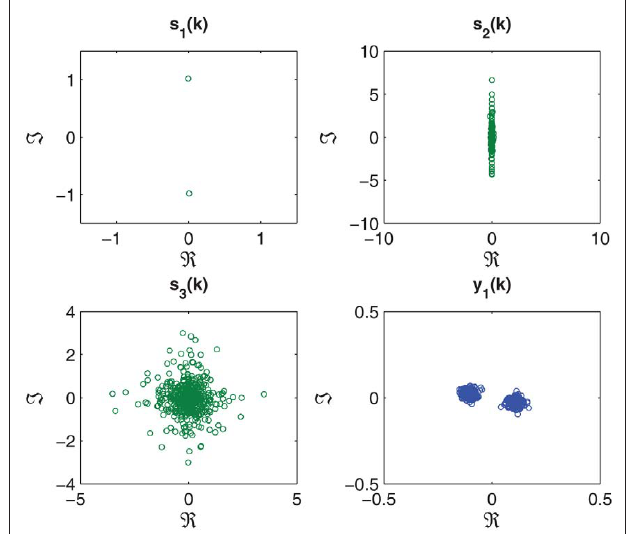
FiGurE 6 | Scatter plots of the original sources s first estimated source y